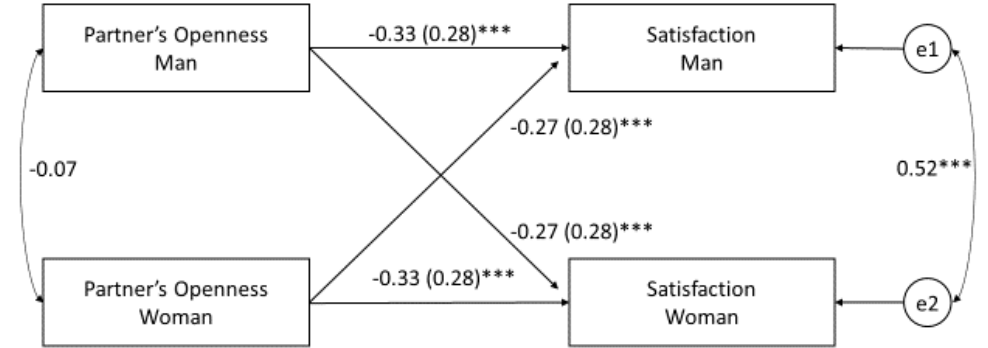
Figure 1. Perception of partner’s openness (opposite pole of reservedness) and relationship satisfaction. Base model. The rectangles represent the independent and dependent variables; the two circles present the latent error terms; the arrows describe the actor and partner effects. The curved double-headed arrows on the left represent the covariances between the independent variables; the curved double-headed arrow on the right represents the correlation between the two error terms (e1, e2: residual errors on satisfaction for males and females, respectively). * p < 0.05; ** p < 0.01; *** p < 0.001; standardized coefficients ( β ) are reported with standard error in parentheses.